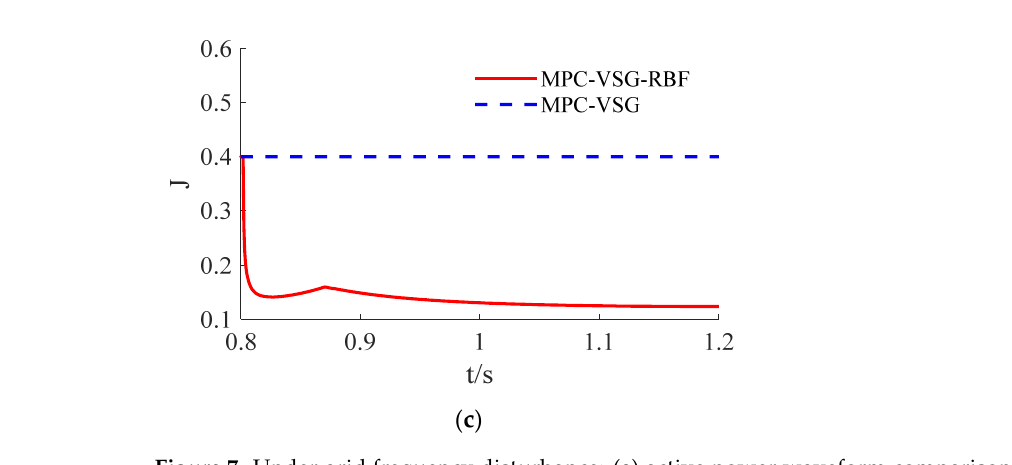
Figure 7. Under grid frequency disturbance: ( a ) active power waveform comparison; ( b ) angular velocity waveform correlation.; ( c ) change in moment of inertia J.